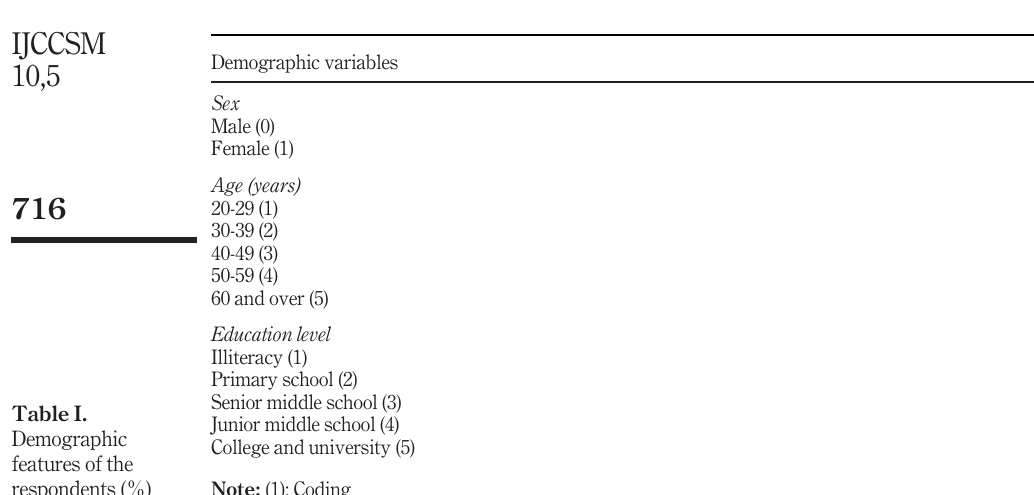
Table I. Demographic features of the respondents